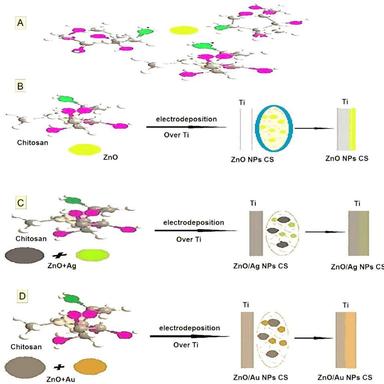
Schematic description of BNC coat (A) related to the interaction between CS positively charged amino groups and ZnO negatively charged particles comprising balanced nanoparticles in the CS. (B) ZnO/CS BNC film on titanium surface processed the electrodeposited mechanism. (C) ZnO/Ag CSBNC film on titanium surface accumulated the electrodeposited mechanism. (D) ZnO/AuCSBNC film on titanium surface preserved the electrodeposited process.